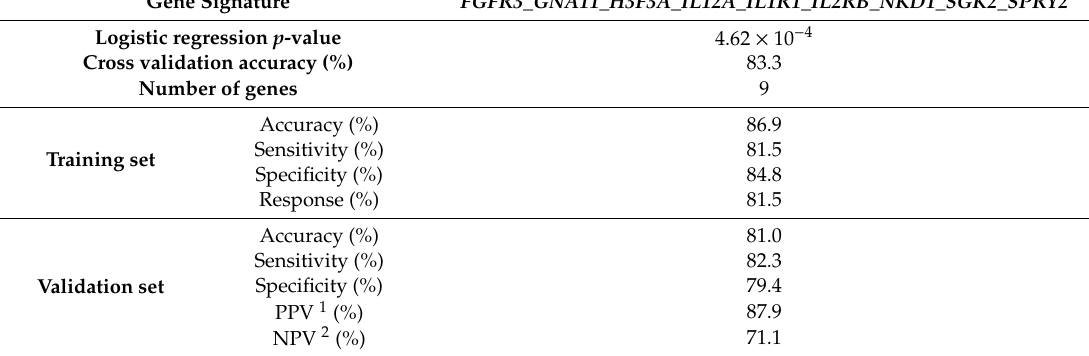
Table 4. Evaluation of the clinical performance of the nine-gene signature to predict PCRT response in patients.